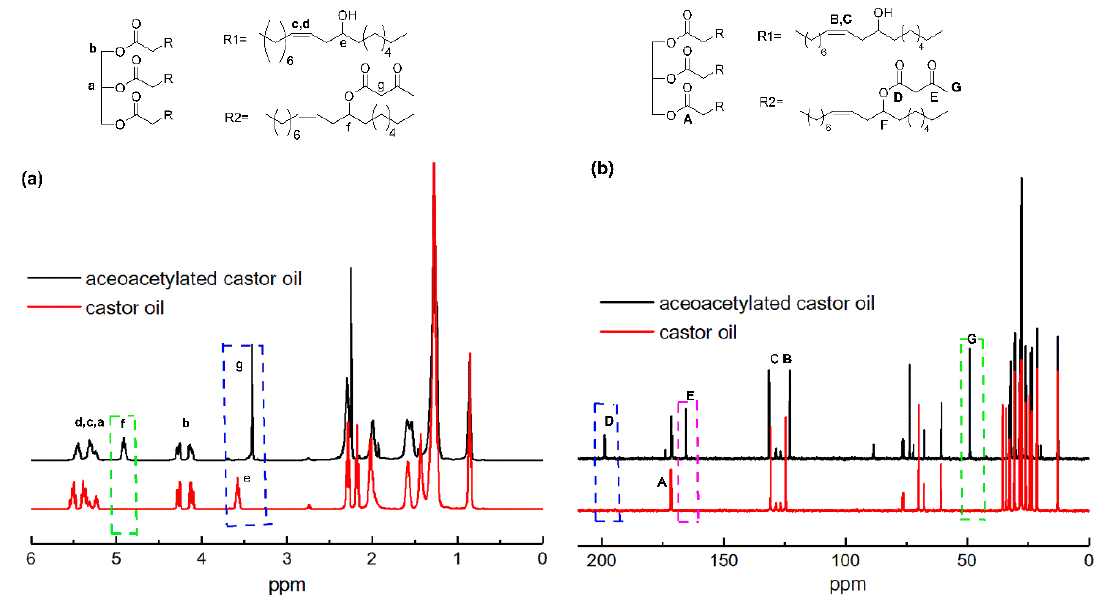
Figure 1. The NMR characterization of acetoacetylated castor oil and castor oil: ( a ) 1 H NMR spectra of acetoacetylated castor oil and castor oil; ( b ) 13 C NMR spectra of acetoacetylated castor oil and castor oil.